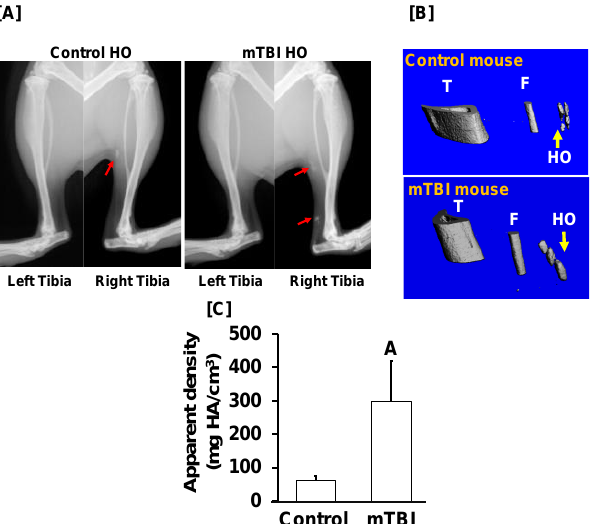
Figure 1. X-ray image and quantitative data describing HO. ( A ) The X-ray image shows HO in the control and mTBI mice 8 weeks after injury. The image was obtained at 40 µm resolution. The red arrow corresponds to HO, ( B ) Micro-CT image of HO in the control and mTBI mice, and ( C ) quantitation of apparent density (BMD) of HO in the control and mTBI mice. Values are the mean ± SEM. N = 5, A p = 0.08 vs. control.